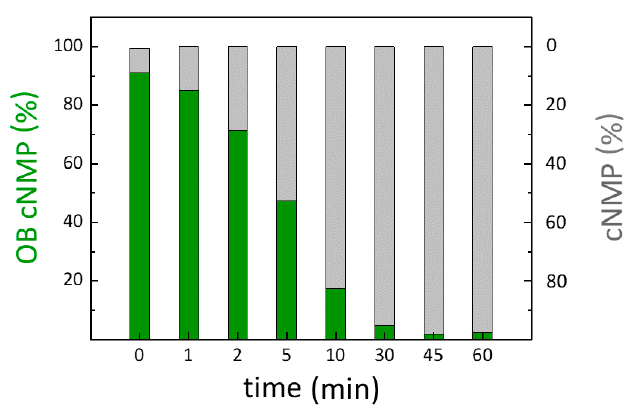
Figure 6. Enzymatic hydrolyses of OB- N (Bu)-cAMP 12 to N (Bu)-cAMP 15 given as normalized values for each time point analyzed. Similar hydrolysis courses were measured for OB-cNMPs 10 and 13 .